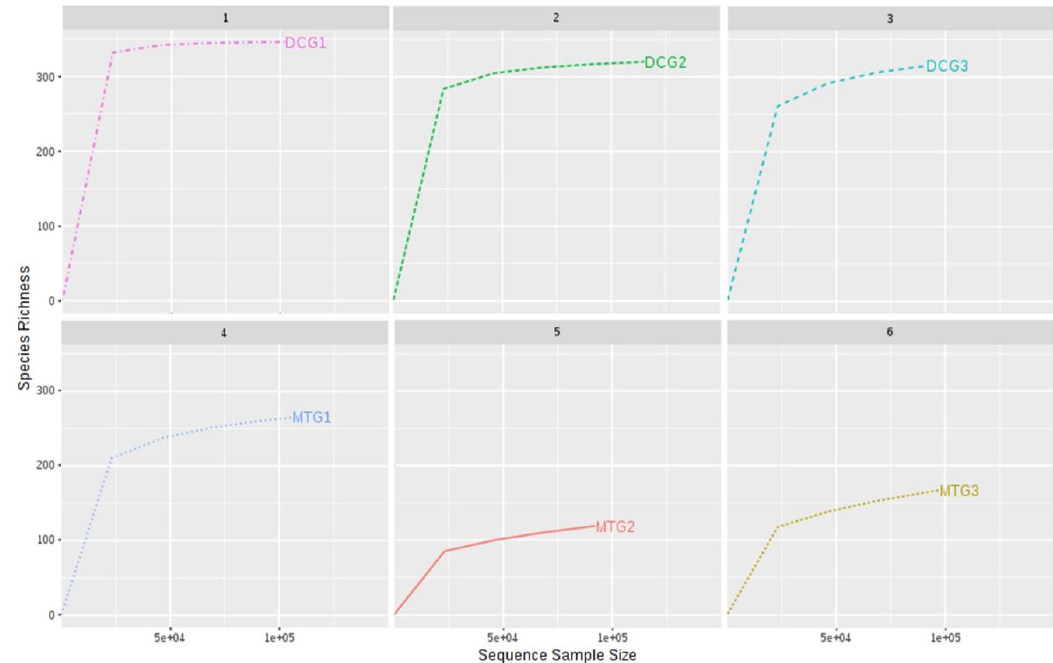
Figure 3. Rarefaction curves drawn for each generation of DC / MT, indicating the proliferation of biomass.